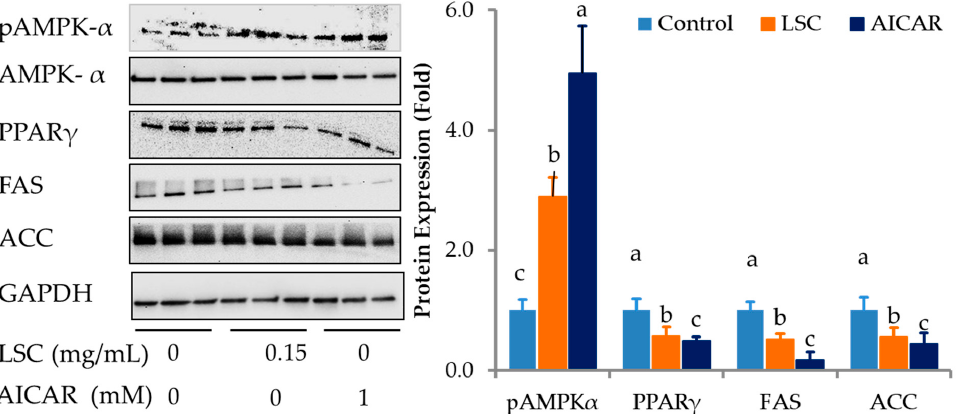
Figure 6. E ff ects of LSC on expression levels of lipolysis and lipogenesis related proteins in adipocytes. Di ff erentiated adipocytes for eight days were treated with LSC or AICAR, an AMPK α agonist, for 12 h. Phosphorylation level of AMPK- α , a key adipocyte di ff erentiation transcriptional factor PPAR- γ , and lipogenic enzymes such as FAS and ACC were determined using Western blot. Protein intensity was determined using ImageJ software. Data are expressed as mean ± standard deviation of three replicates. Di ff erent alphabets in the fi gure indicate signi fi cant di ff erences at p < 0.05.